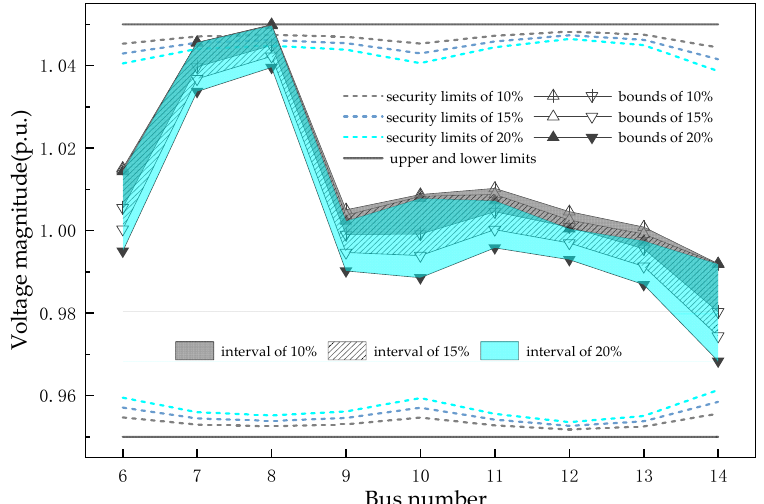
Figure 10. Load voltage magnitudes obtained at different tolerances.